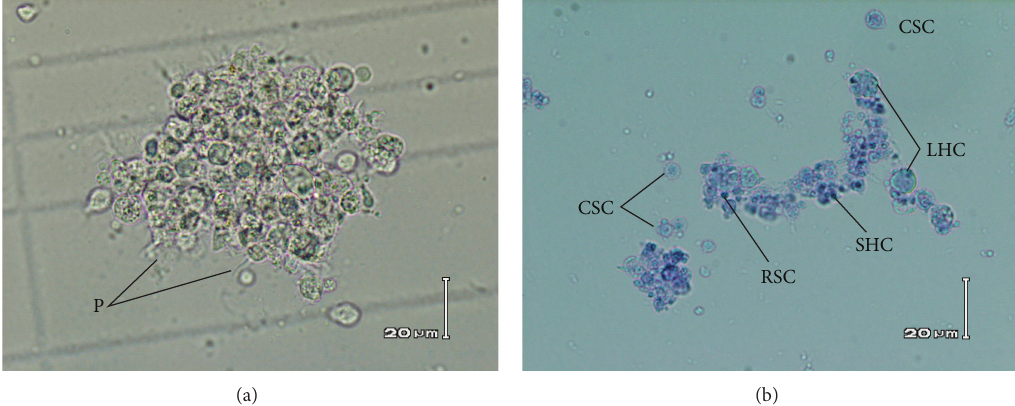
Figure 5: Acanthaster planci . Gram stain of clusters formed 2 hours after injection of oxbile. (a) Fresh sample and (b) H&E stain. Colourless spherule cell (CSC), large hyaline cell (LHC), pseudopodia (P), red spherule cell (RSC), and small hyaline cell